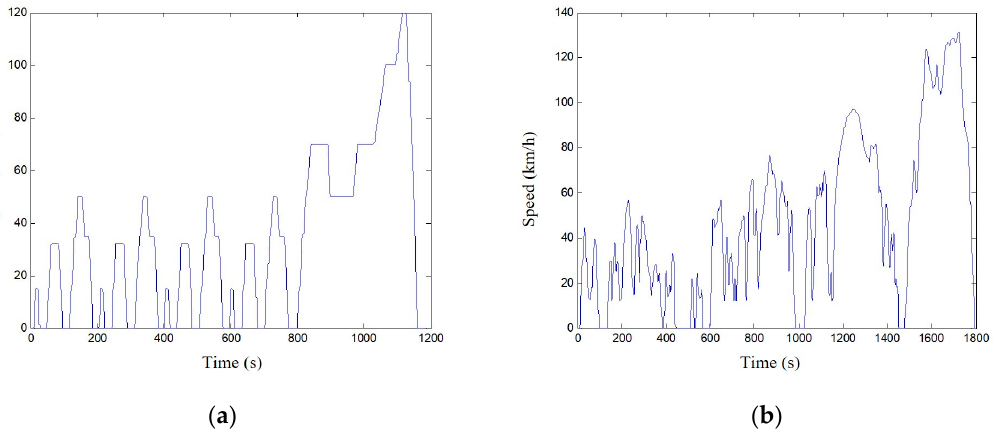
Figure 6. ( a ) NEDC cycle test condition; ( b ) WLDP cycle test condition.